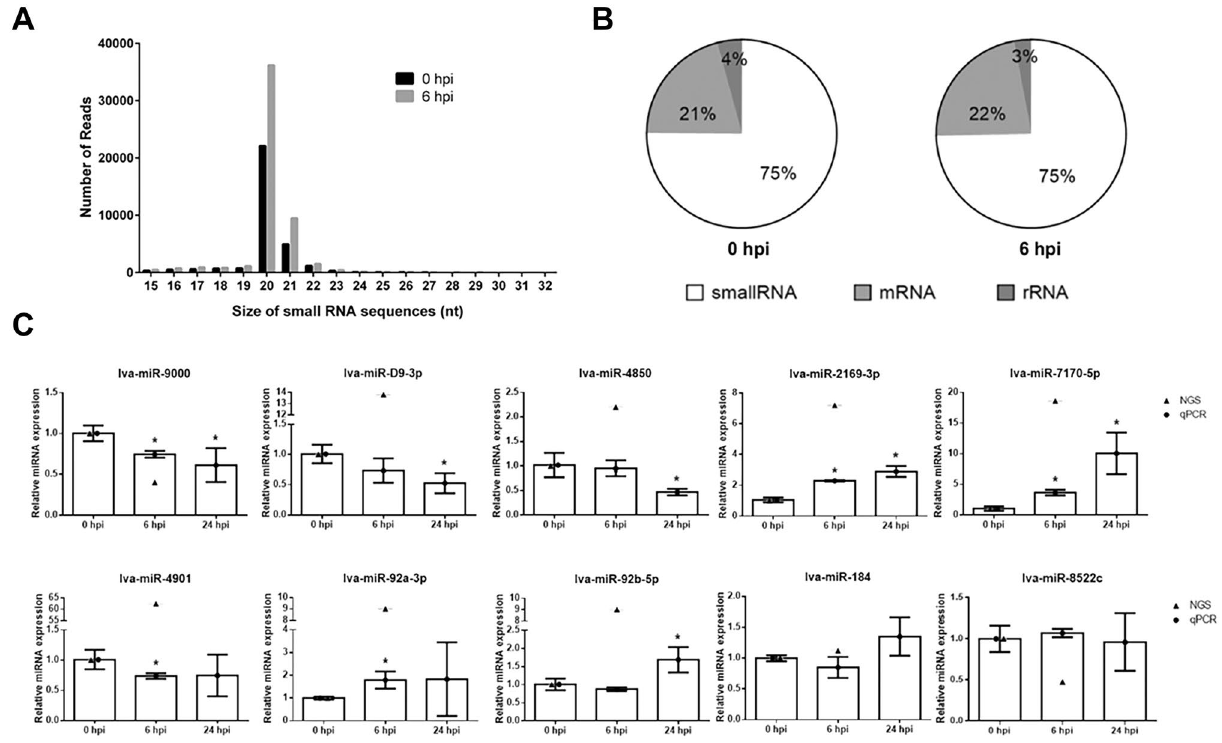
Figure 1. Transcriptomic profiles of miRNAs from P. vannamei hemocytes in response to VP AHPND infection. ( A ) Length distribution and abundance of sRNAs from hemocytes of VP AHPND -challenged P. vannamei at 0 and 6 hpi. ( B ) Composition of RNAs in each sRNA-Seq library. ( C ) Total RNA from VP AHPND -infected P. vannamei hemocytes was used as a template for specific stem-loop first-strand cDNA synthesis. The relative expression levels of 10 miRNAs were determined by qRT-PCR at 0, 6, and 24 hpi and normalized against U6 as the internal reference. Data are shown as the mean ± 1 SD, derived from three independent repeats. Asterisks indicate significant differences at P < 0.05